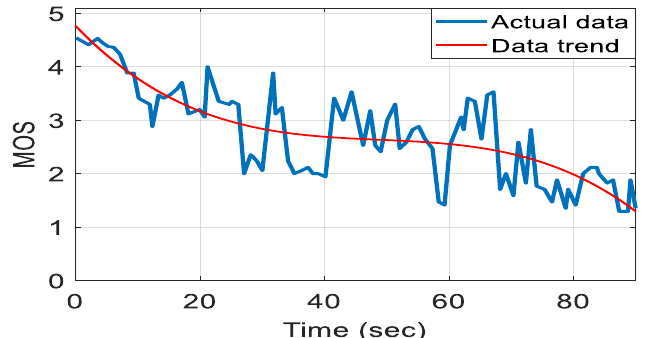
Figure 17. Averaged mean opinion score (MOS) for the subjective test.